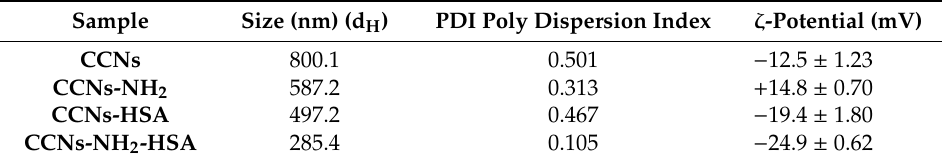
Table 1. Dynamic Light Scattering (DLS) characterization of CCNs samples.